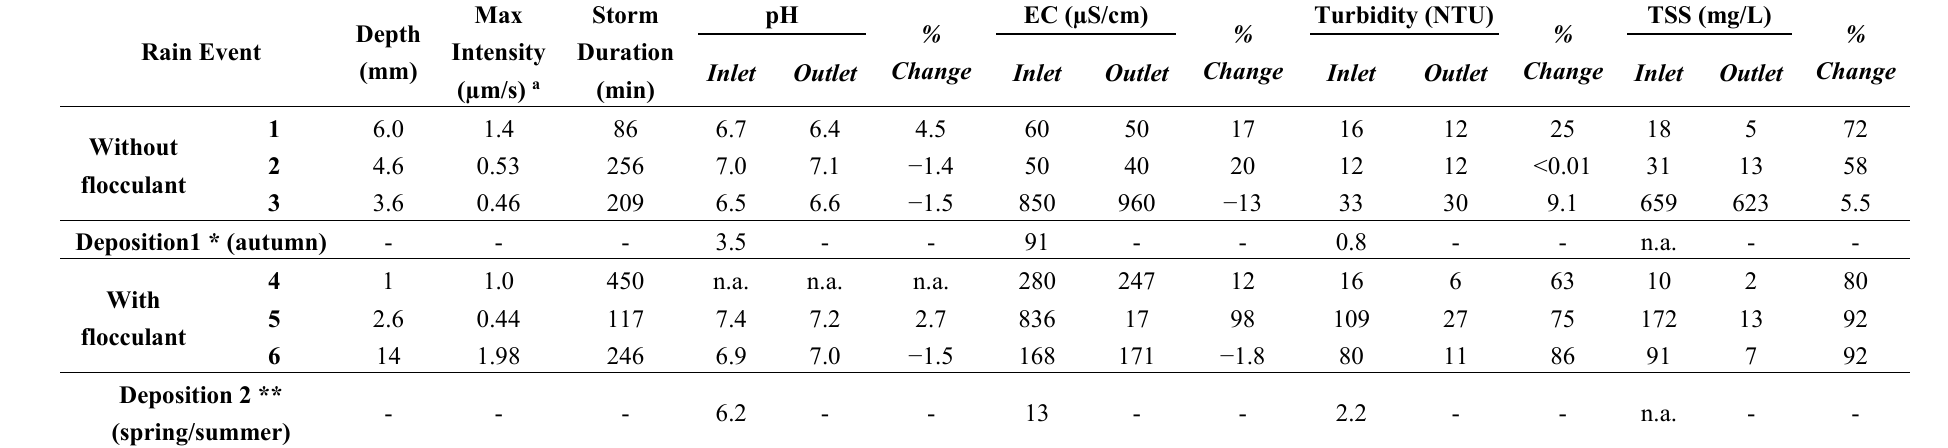
Table 1. Partial event mean concentrations (pEMCs) of pH, EC, turbidity and TSS from the six different rain events and the two total deposition samples. Inlet = untreated stormwater runoff sampled before entering the disc filter, Outlet = treated water after treatment in the disc